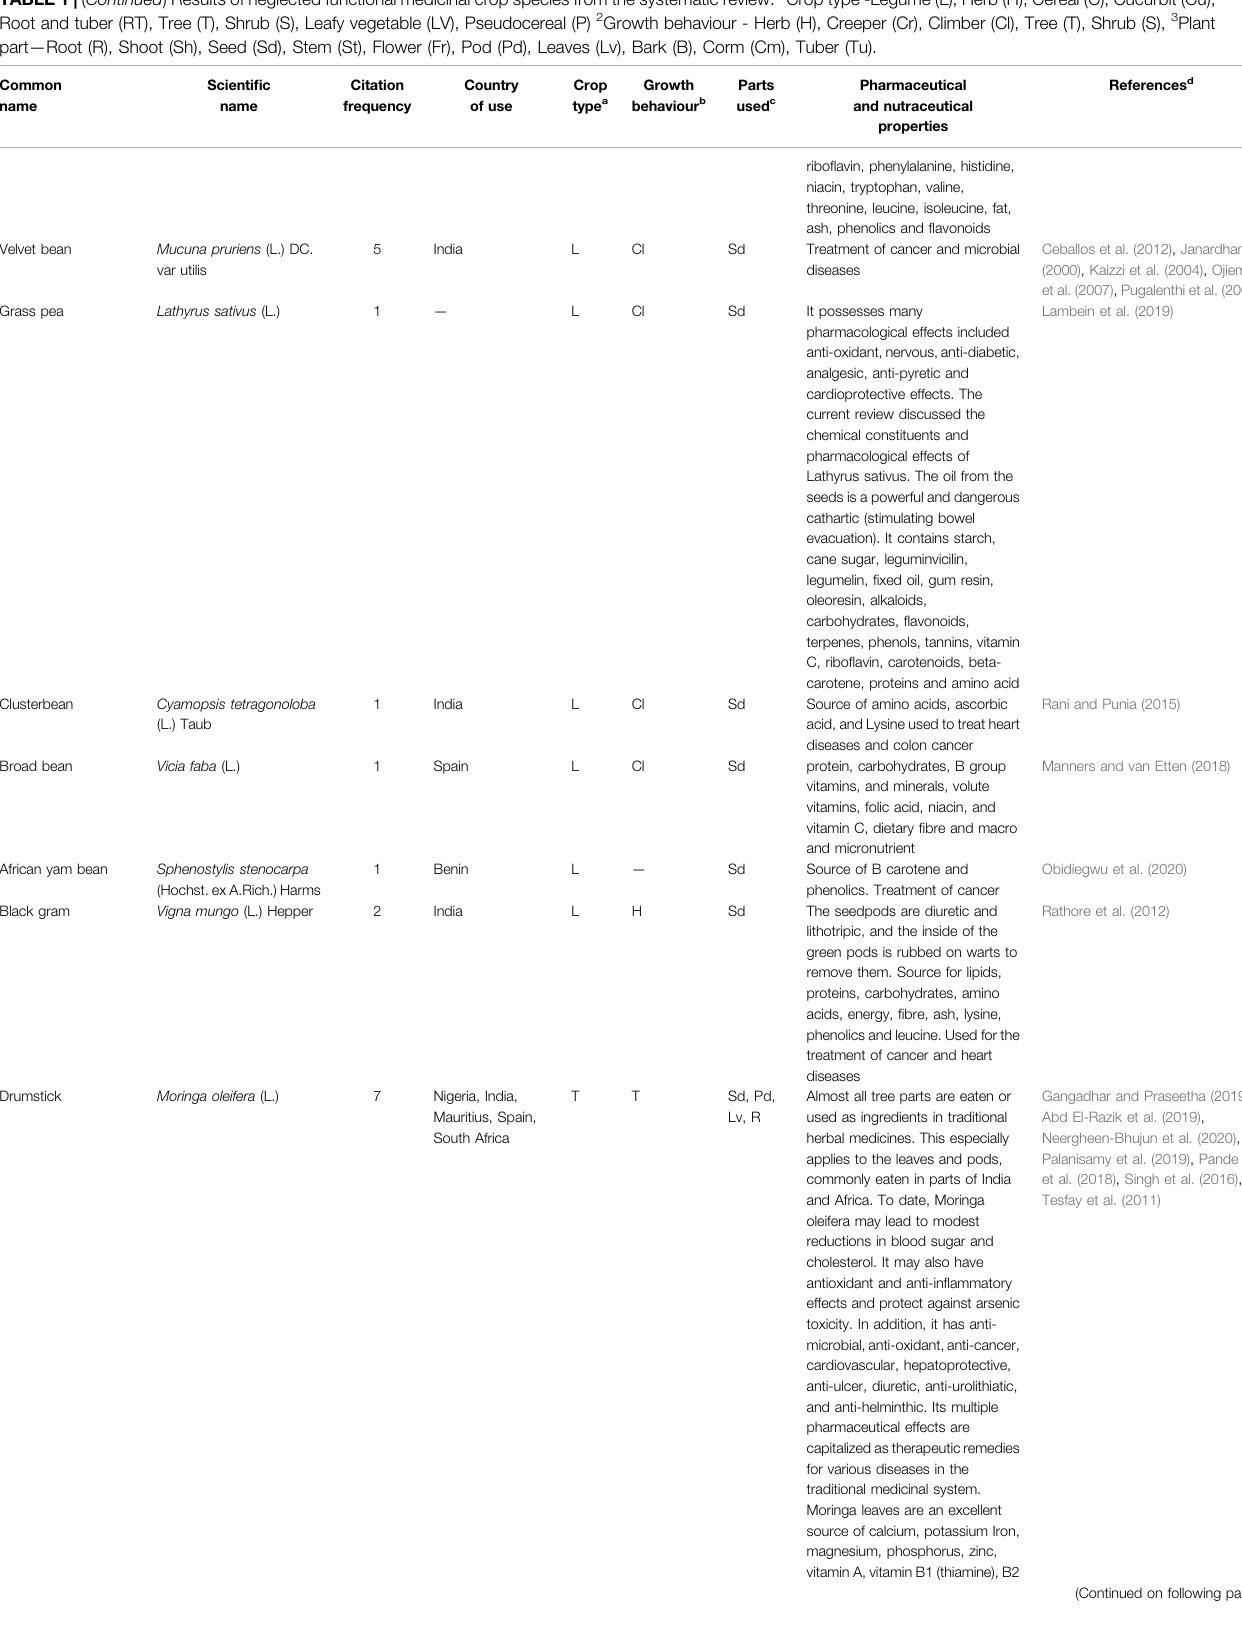
TABLE 1 | ( Continued ) Results of neglected functional medicinal crop species from the systematic review. 1 Crop type -Legume (L), Herb (H), Cereal (C), Cucurbit (Cu), Root and tuber (RT), Tree (T), Shrub (S), Leafy vegetable (LV), Pseudocereal (P) 2 Growth behaviour - Herb (H), Creeper (Cr), Climber (Cl), Tree (T), Shrub (S), 3 Plant part — Root (R), Shoot (Sh), Seed (Sd), Stem (St), Flower (Fr), Pod (Pd), Leaves (Lv), Bark (B), Corm (Cm), Tuber